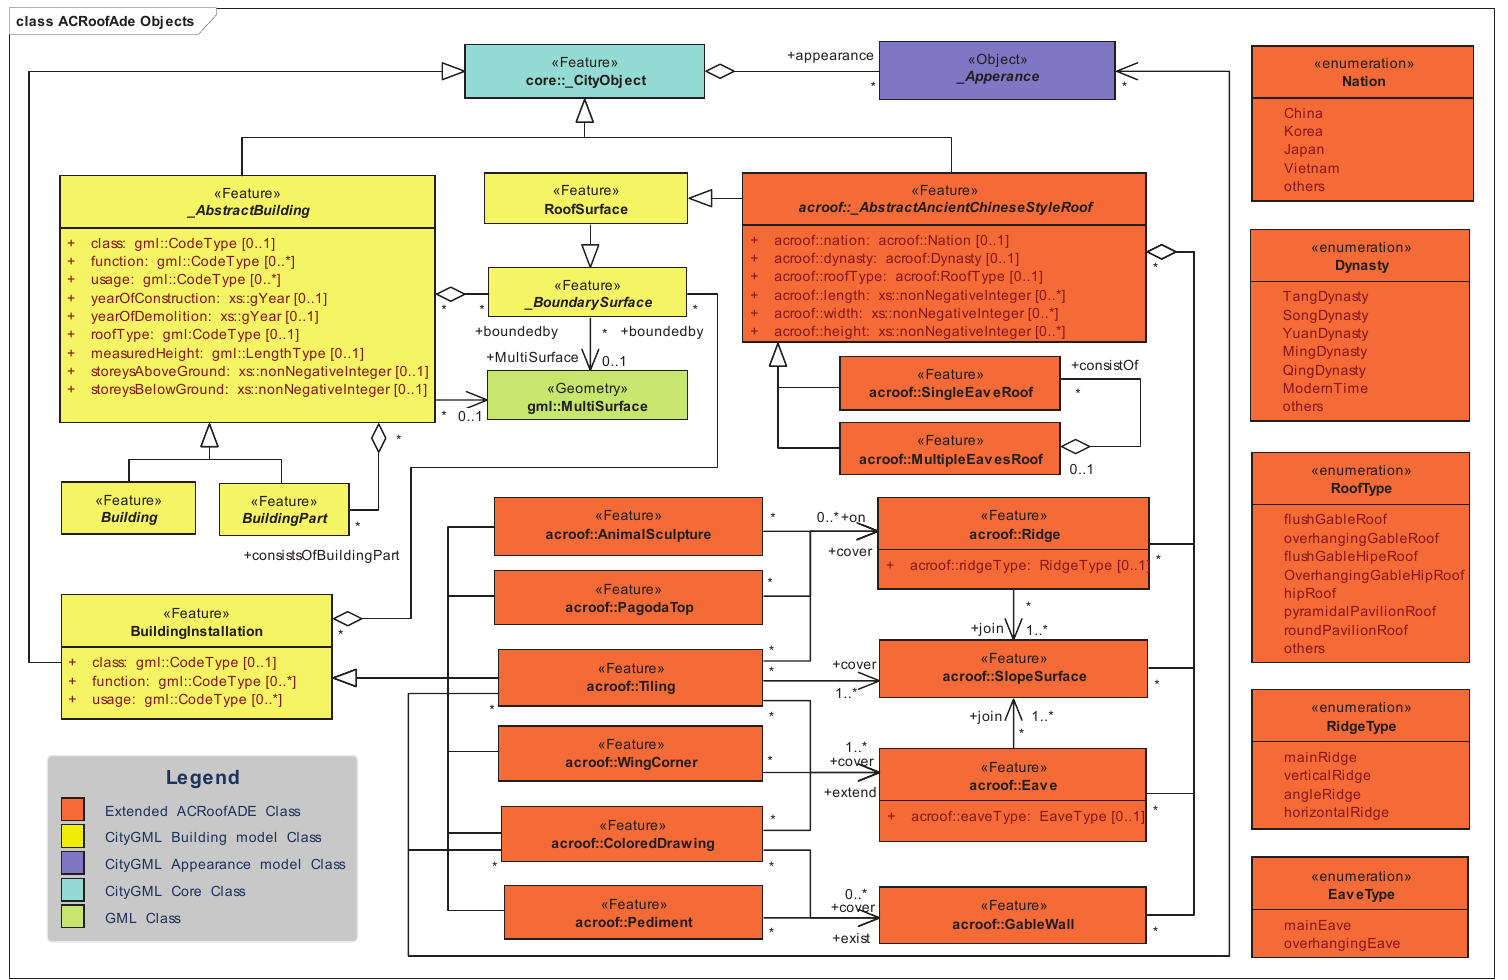
Figure 7. ACRoofADE–CityGML application domain extension for ancient Chinese-style architectural roofs (for the different colors in the figure, readers are referred to the electronic version of this